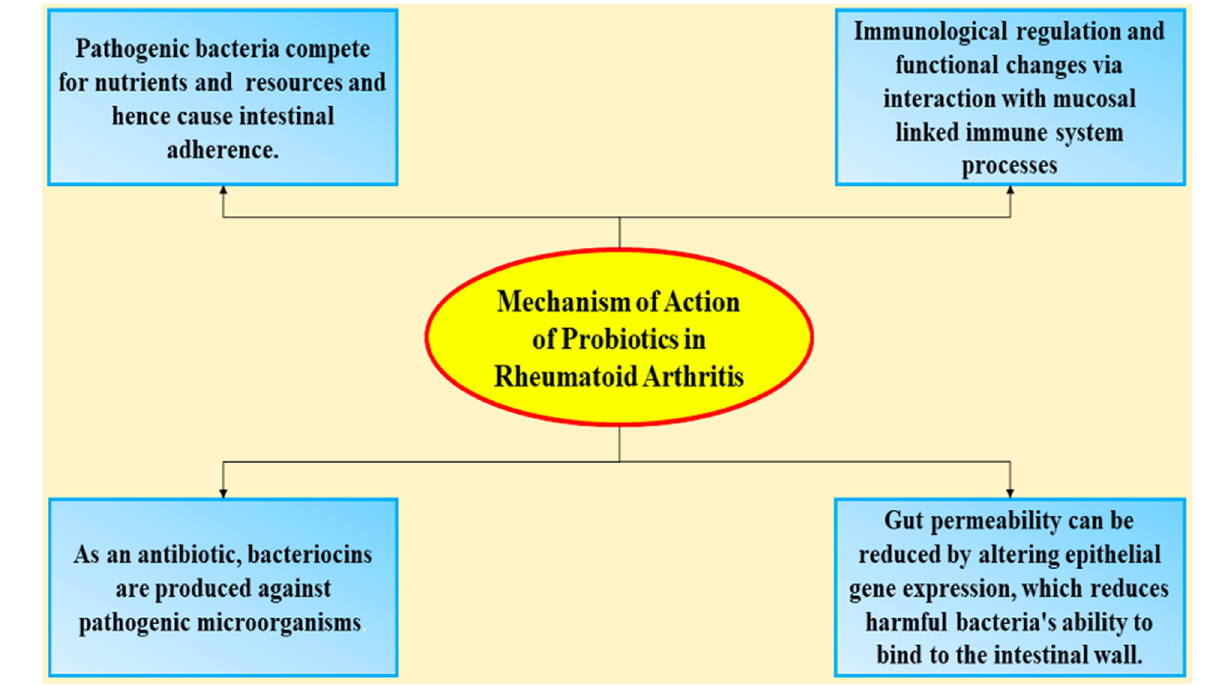
Figure 1. Probiotics in rheumatoid arthritis.